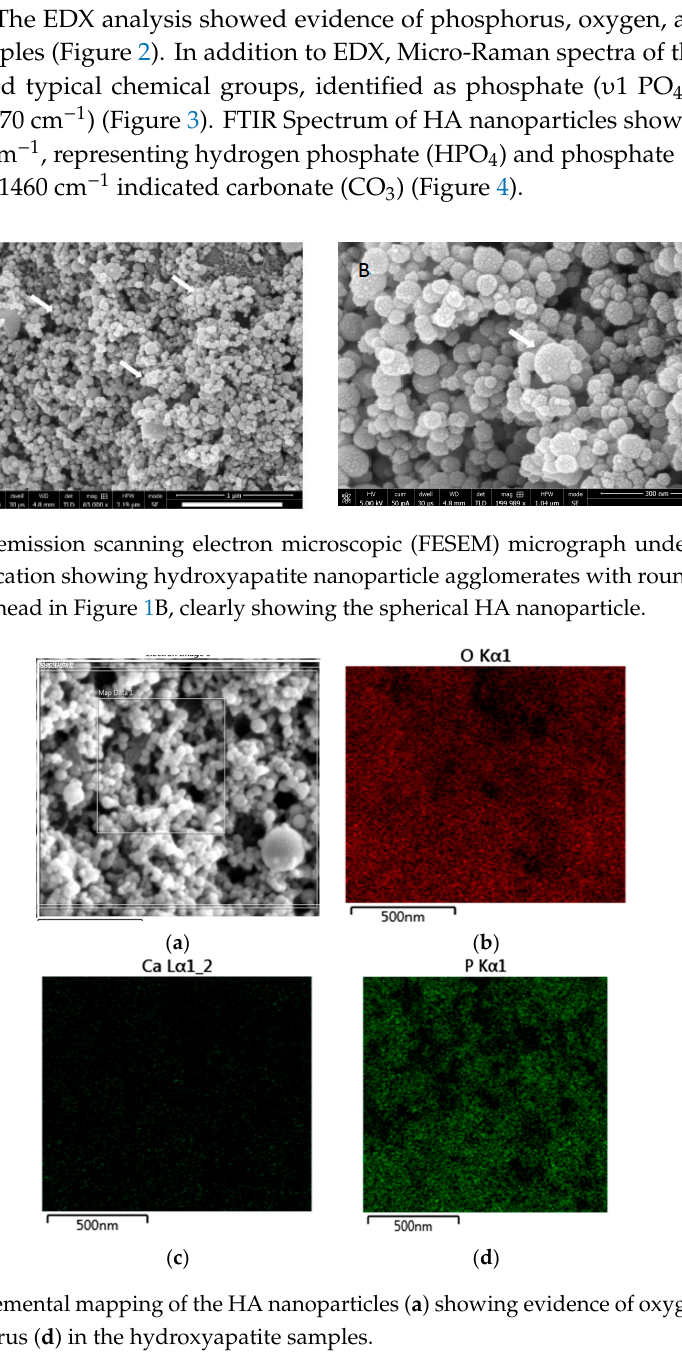
Figure 3. Typical Raman spectra of the HA showing chemical groups identified by Micro-Raman analysis that could be identified as phosphate ( υ 1 PO 4 ~960 cm − 1 ) and carbonate (CO 3 ~1070 cm − 1 ).